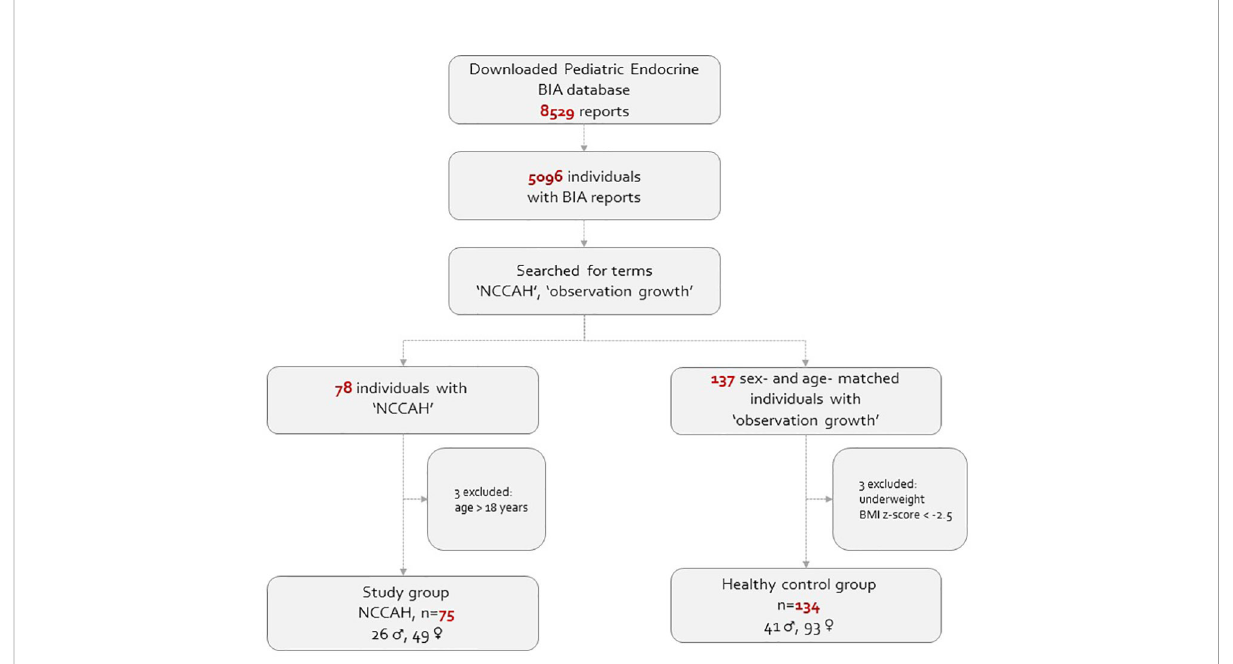
FIGURE 1 The study population fl